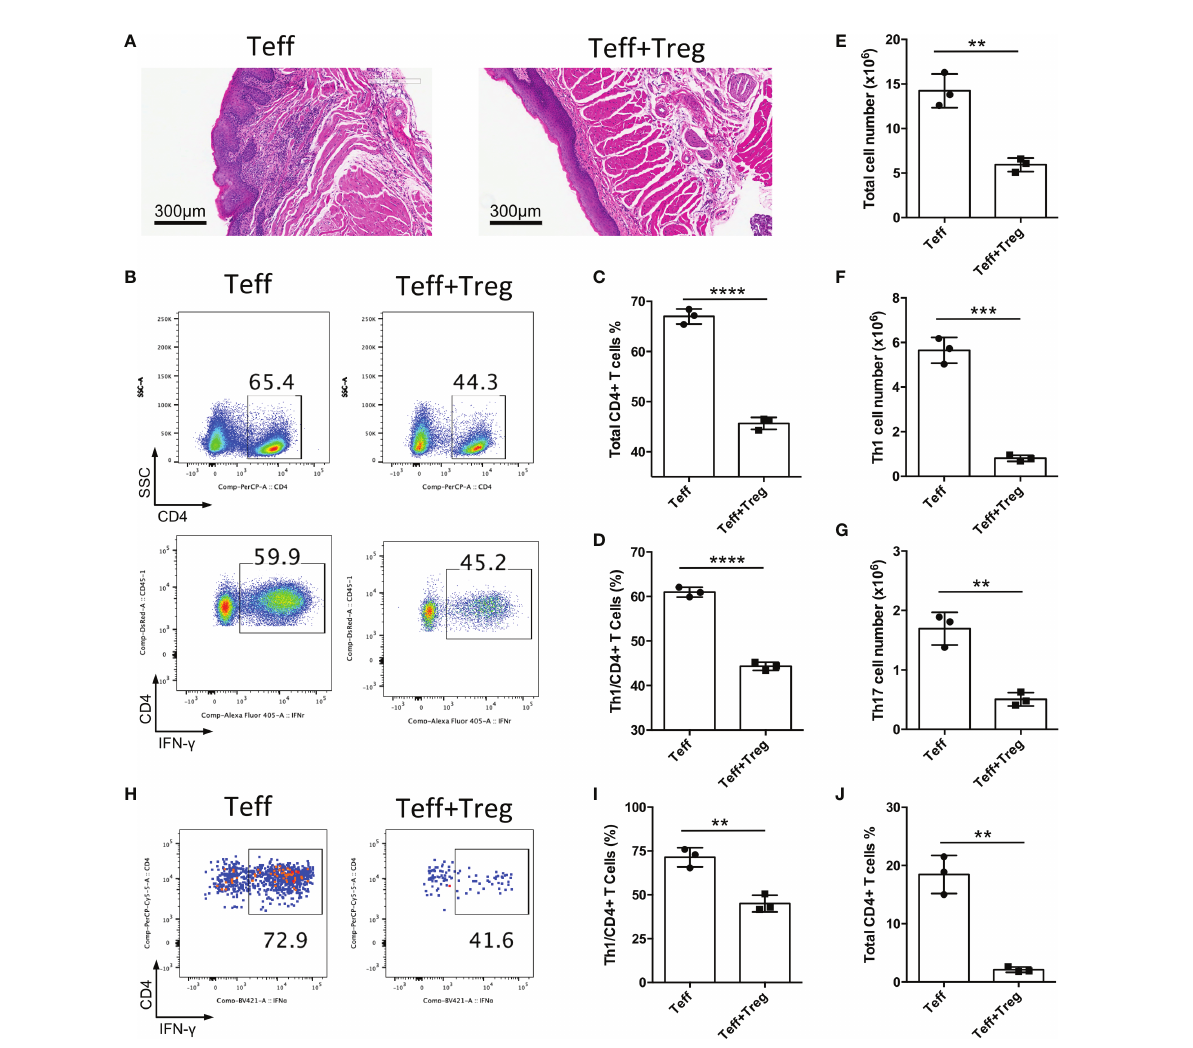
FIGURE 4 Adoptive transfer of Treg cells suppresses in fl ammation in oral mucosa. CD4 + CD25 - CD45RB high T cells sorted by fl ow cytometry from the spleens and peripheral lymph nodes (PLNs) of CD45.1 mice were injected into Rag1 -/- mice (Teff), and CD4 + CD25 + Foxp3(eGFP) + Treg cells of CD45.2 mice were co-transferred to treat the oral in fl ammation (Teff+Treg) (n=3). (A) Representative histology images of oral mucosa sections. (B-D) Representative fl ow cytometry plots (B) and bar graphs showing frequencies of CD45.1 + Teff cells (C) and Th1 cells (D) in DLNs of the oral cavity. (E-G) Bar graphs showing the numbers of total immune cells (E) , Th1 cells (F) and Th17 cells (G) in DLNs of the oral cavity. (H-J) Representative fl ow cytometry plots (H) and bar graphs showing frequencies of Th1 cells (I) and total Teff cells (J) in the oral mucosa. Data are representative of two independent experiments. Summary data are presented as mean ± SD. **p < 0.01, ***p < 0.001, ****p < 0.0001, unpaired two-tailed Student ’ s t